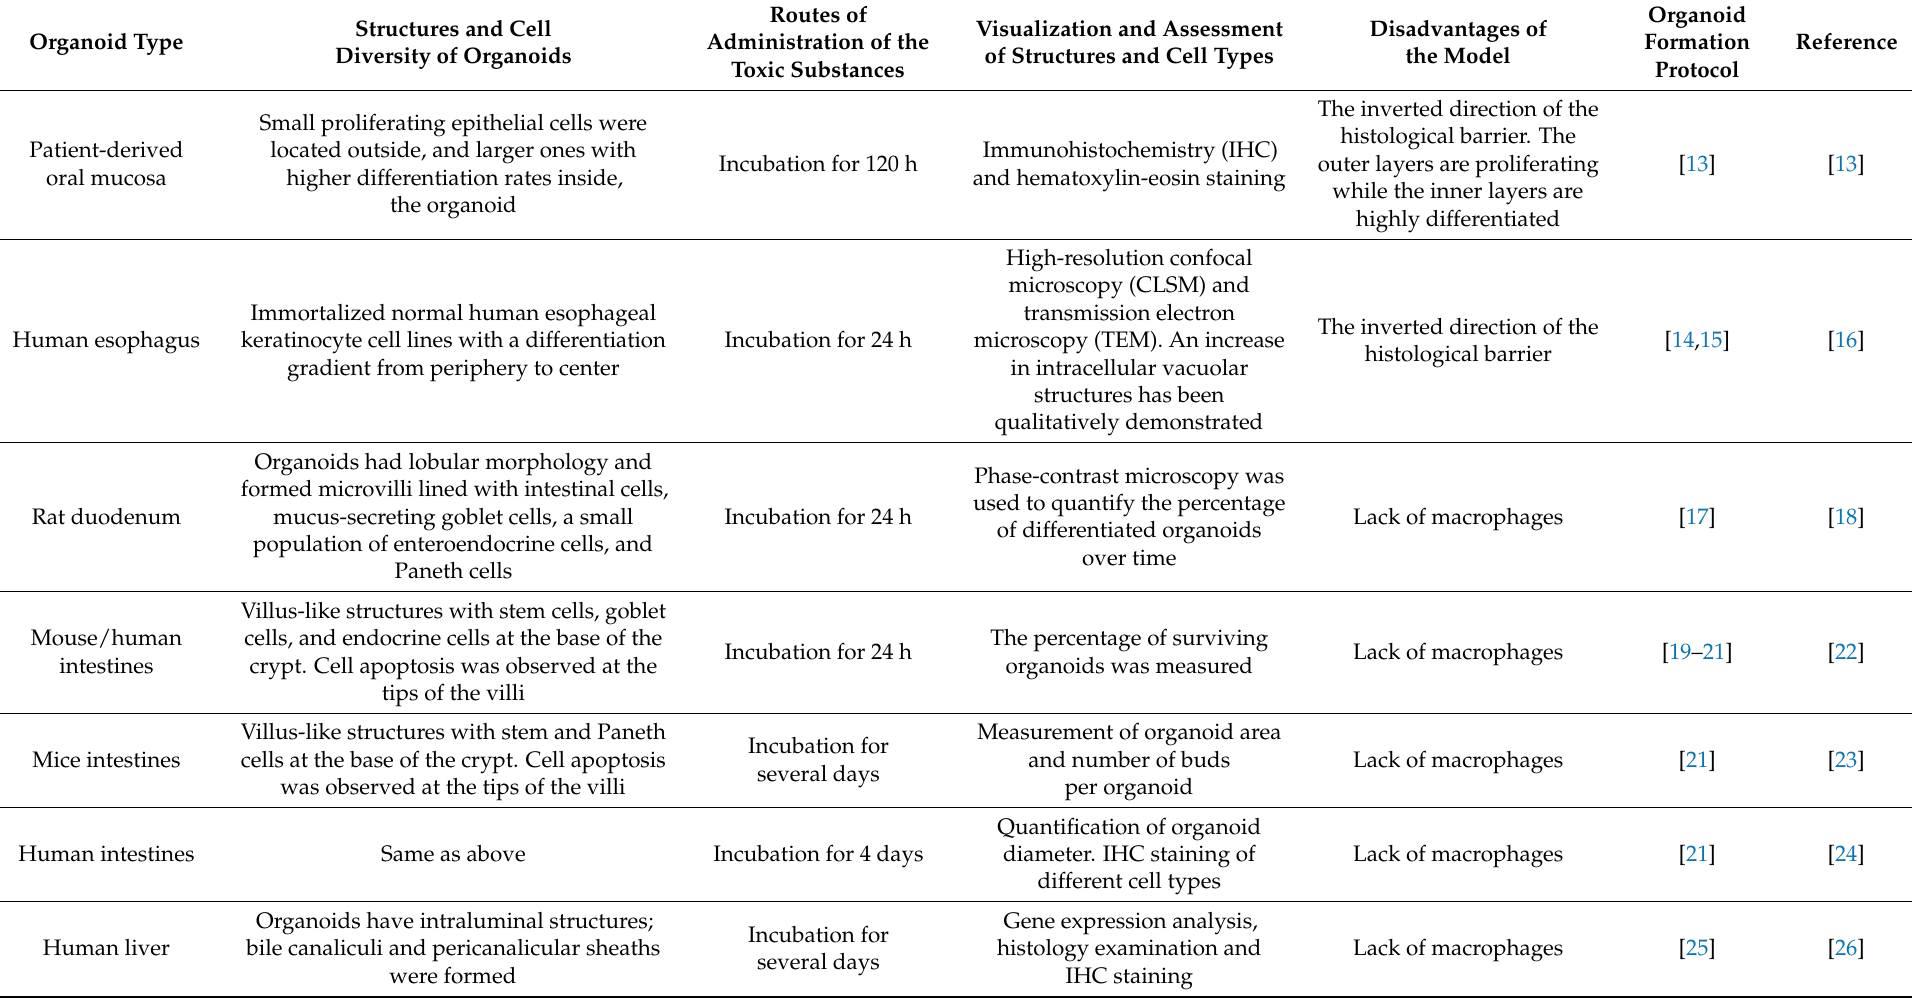
Table 2. Morphological studies of organoids in toxicological studies in